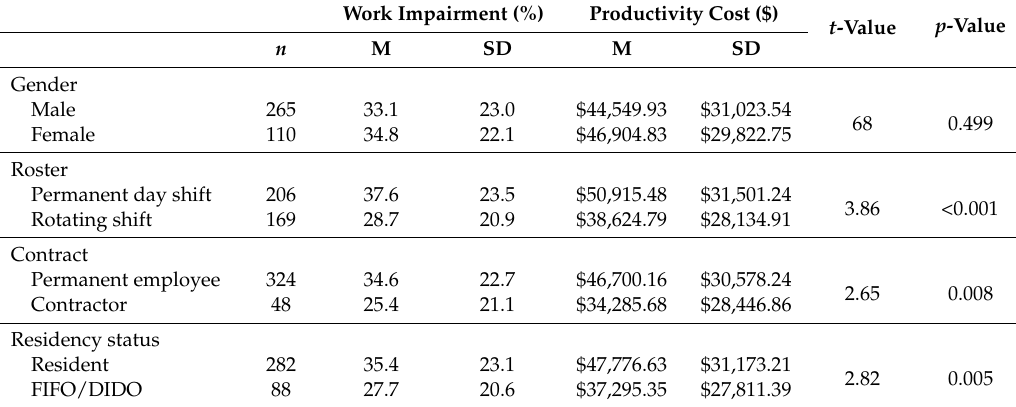
Table 2. Group differences on work impairment percentage and annual productivity cost per